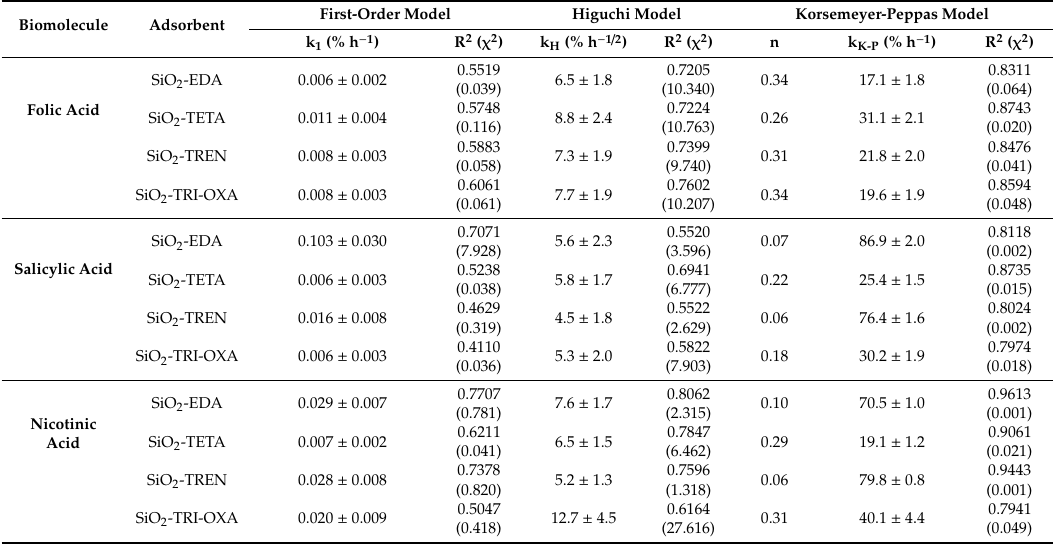
The drug release parameters calculated for the first-order, the Higuchi and